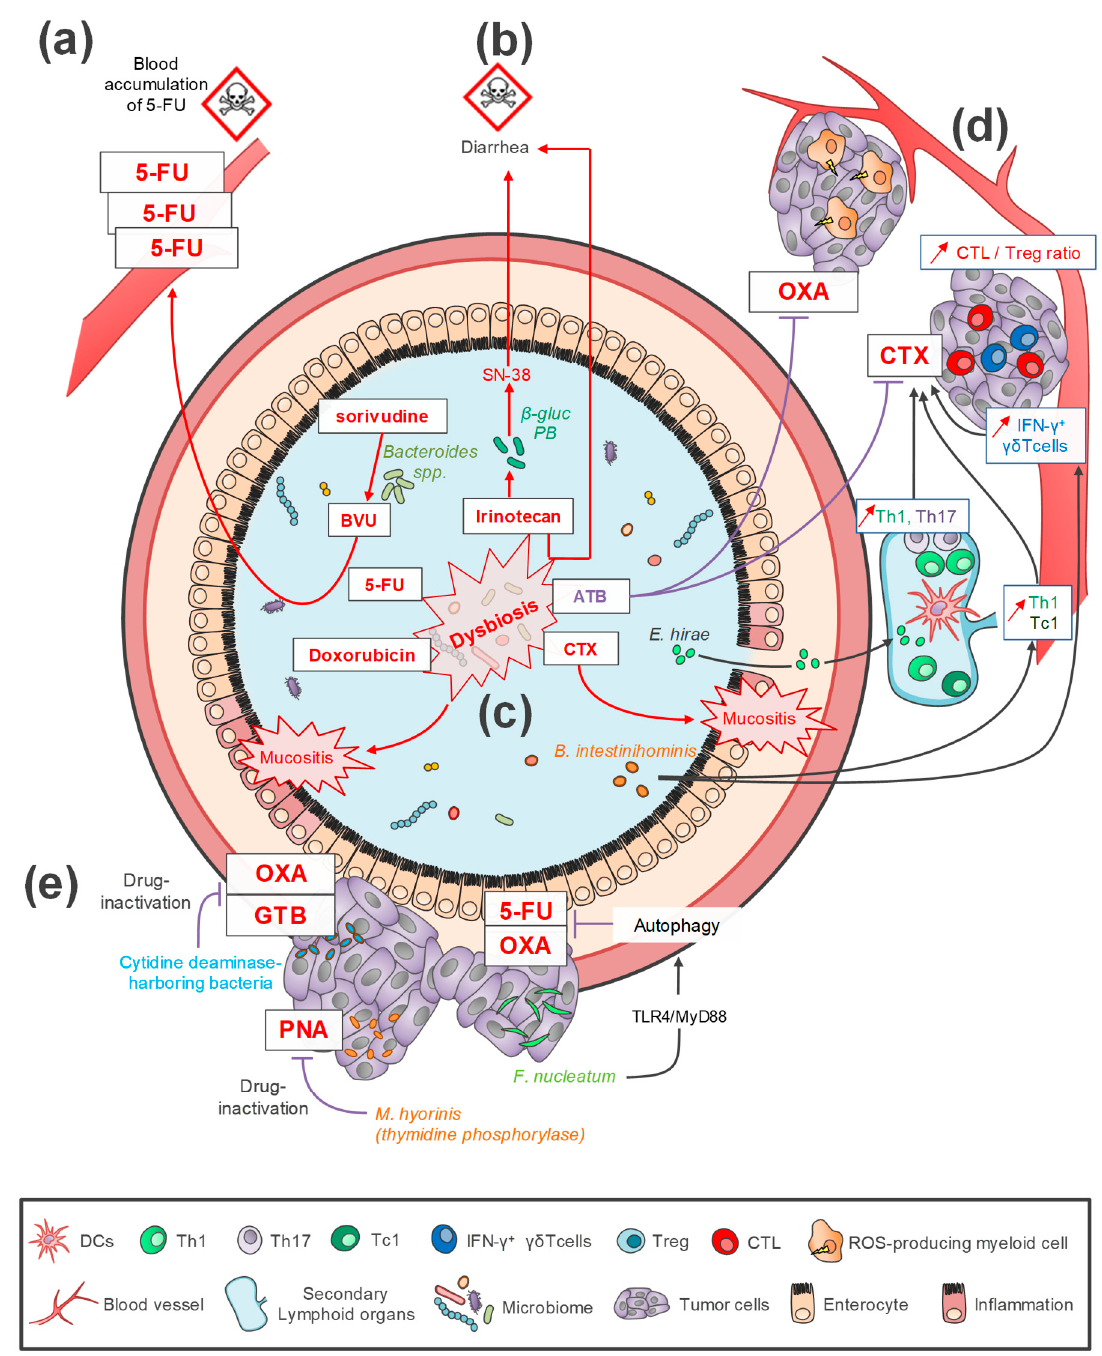
Figure 1. Impacts of intestinal microbiota on chemotherapy toxicity and efficacy. ( a–b ) Microbe-mediated xenometabolism could be linked to an increase of chemotherapy toxicity. ( a ) Bacteroides species would convert sorivudine into an intermediate component (BVU), which inhibits the degradation of 5-FU, leading to its toxic accumulation in the blood. ( b ) The β -glucuronidase-producing bacteria ( β -gluc-PB ) could induce an increase of the irinotecan active metabolite (SN-38) in the gut, which is associated with diarrhea. (c) Chemotherapy treatment could induce dysbiosis (microbial composition alteration), as has been noticed for doxorucibin, 5-FU, cyclophosphamide (CTX), and irinotecan. A dysbiosis could impact chemotherapy efficacy and/or side effects (diarrhea, mucositis, etc.). ( d ) Gut microbiota could impact chemotherapy efficacy by immune modulations or/and bacterial translocation to lymphoid organs. OXA chemoresistance has been described in antibiotics (ATB)-treated mice and correlated to a decrease of ROS-producing myeloid anti-tumor